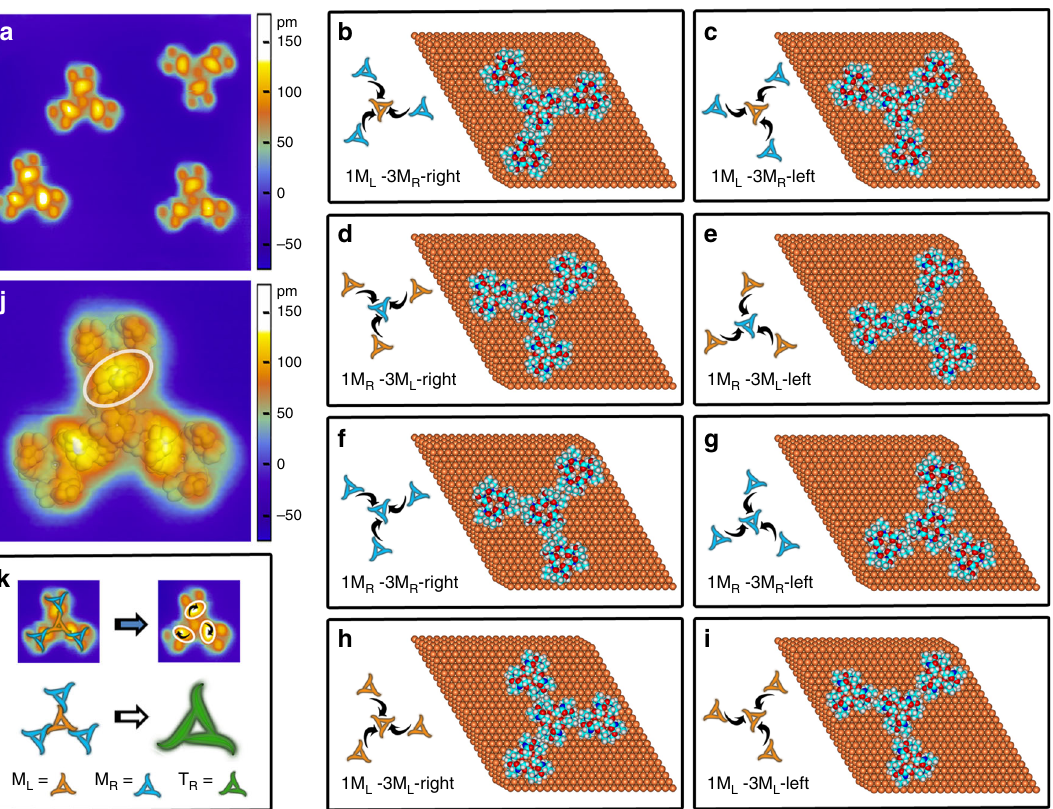
Fig. 2 Individual valinomycin tetramer. a STM image (18 nm × 18 nm) of valinomycin tetramers on Cu(111) surface at 78 K. b – i Eight typical calculated molecular models of valinomycin tetramer. The adsorption con fi gurations of tetramer, subunit-pairing way, and outer subunit-attacking mode were shown from b to i . In calculated molecular models, copper, carbon, nitrogen, oxygen, and hydrogen atoms are displayed in brass, cyan, blue, red, and gray, respectively. j STM image (6 nm × 6 nm) of valinomycin tetramers superimposed by calculated electron density. The binding site between M L and M R subunits was highlighted by a white circle. k Schematic diagram of chirality ampli fi cation at the fi rst level of hierarchical